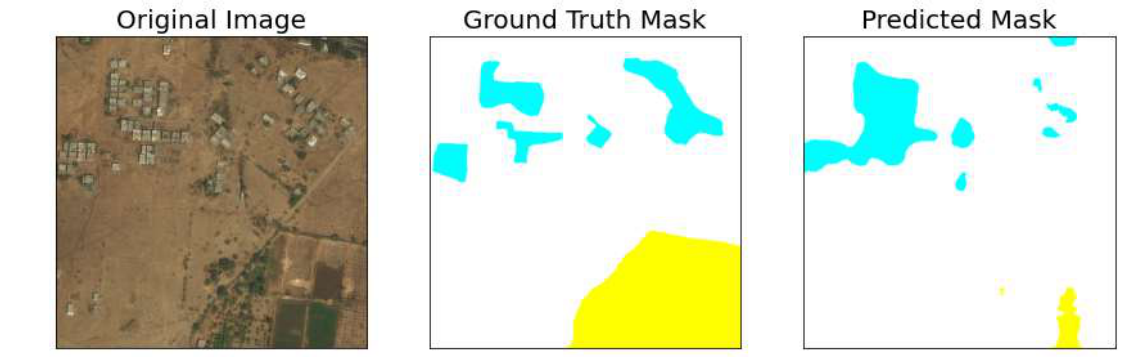
Figure 3. Trained model results.